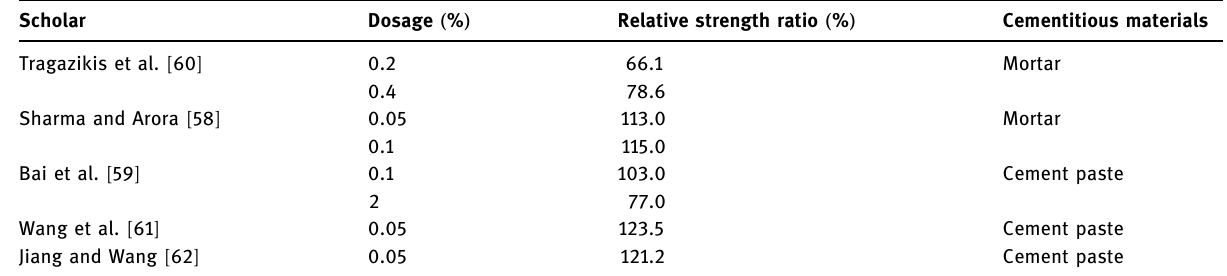
Table 4: Flexural strength of GP - modi fi ed cementitious materials